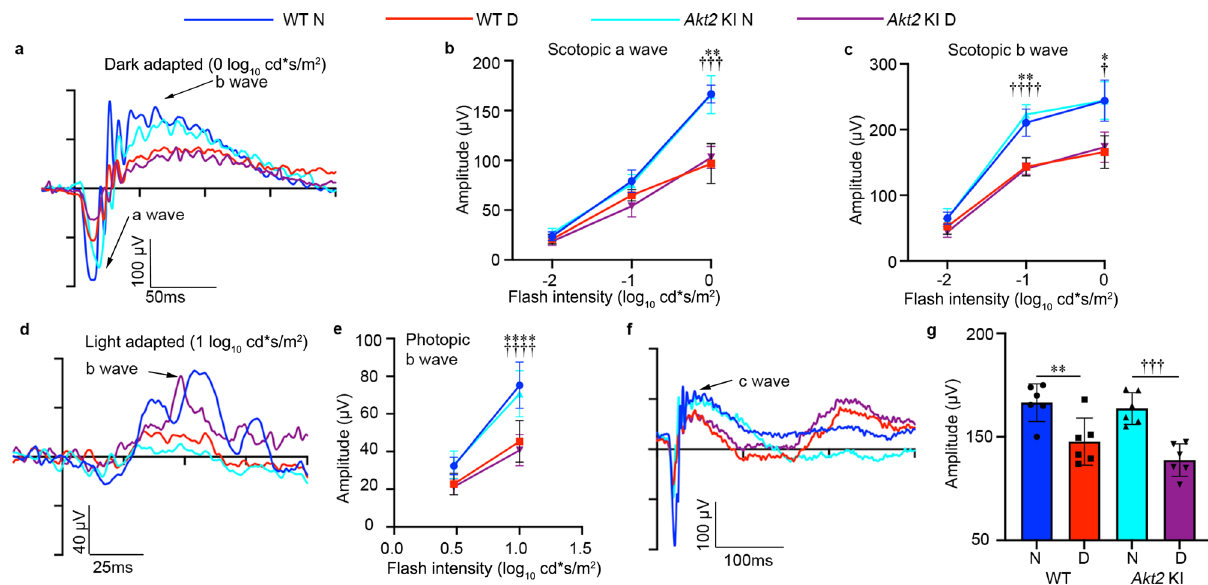
Fig. 5 | ERG suggests that RPE-speci fi c Akt2 KI does not impact the diabetes- induced disruption of retinal function (4 month duration of diabetes). a Representative scotopic ERG a- and b- waveforms, showing response to a 0 log 10 cd·s/m 2 stimulus luminance after overnight dark adaptation. Scotopic ( b ) a-wave and ( c ) b-wave amplitudes were decreased in both WT and Akt2 KI diabetic mice compared to appropriate nondiabetic controls. Akt2 overexpression in the RPE ( Akt2 KI) did not exhibit any protective effect on diabetic-induced ERG abnormal- ities. d Representative photopic ERG b-waveforms response to a 1 log 10 cd·s/m 2 stimulus luminance after light adaptation. e RPE-speci fi c Akt2 KI had no protective effect on the diabetes-induced detrimental changes in the photopic b-wave. f RepresentativeERGc-waveforms. g c-waveamplitudeisdecreasedinWTand Akt2 KI diabetic mice compared to appropriate nondiabetic controls. There was no signi fi cant change in the c-wave between diabetic WT and Akt2 KI groups.